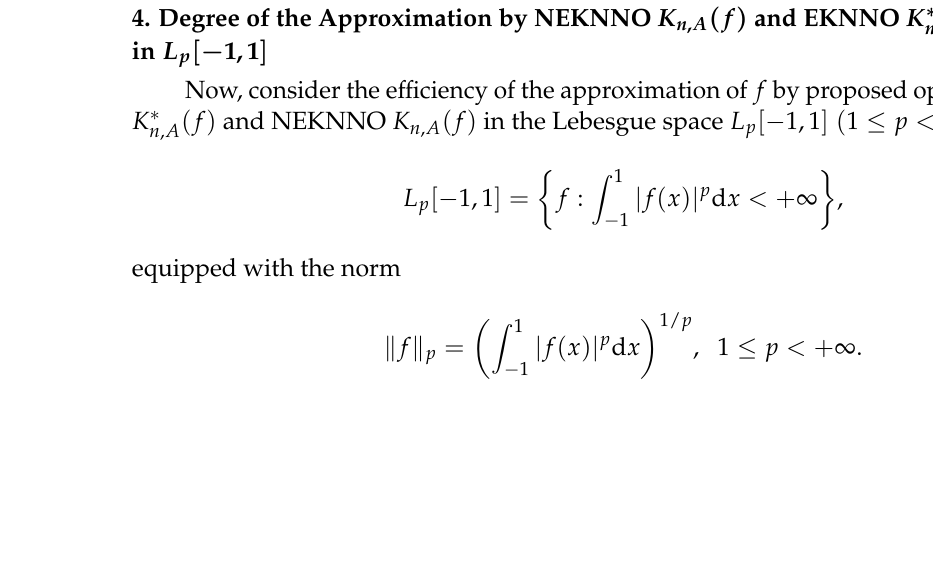
Figure 2. The comparison of approximation effects of operators K n , A ( f , x ) and N n ( f , x )